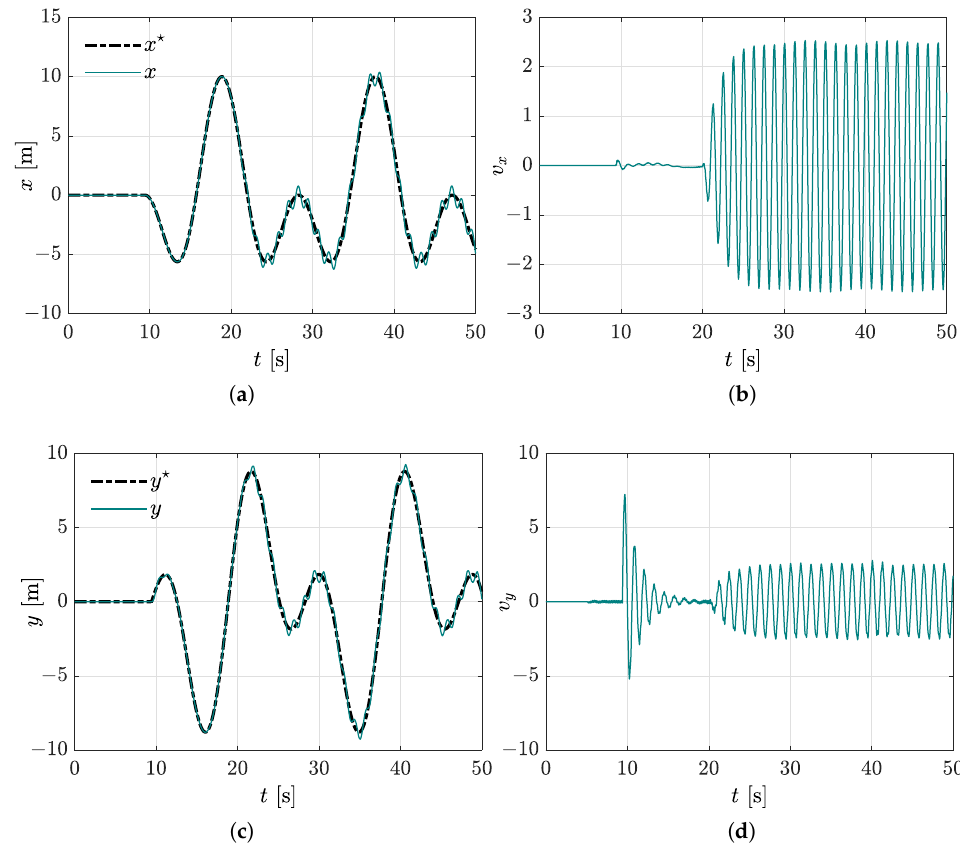
Figure 13. Controlled vertical dynamics, case 2.2. ( a ) Desired x (cid:63) position tracking. ( b ) Virtual controller v x . ( c ) Desired y (cid:63) position tracking. ( d ) Virtual controller v y